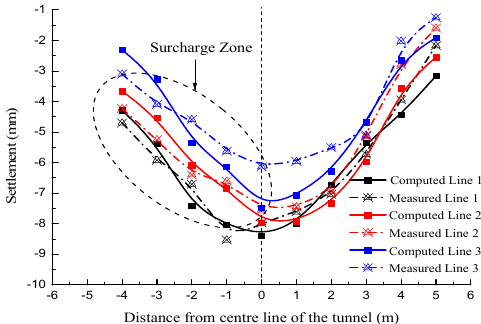
Figure 25. Comparison of final road settlement monitoring results.